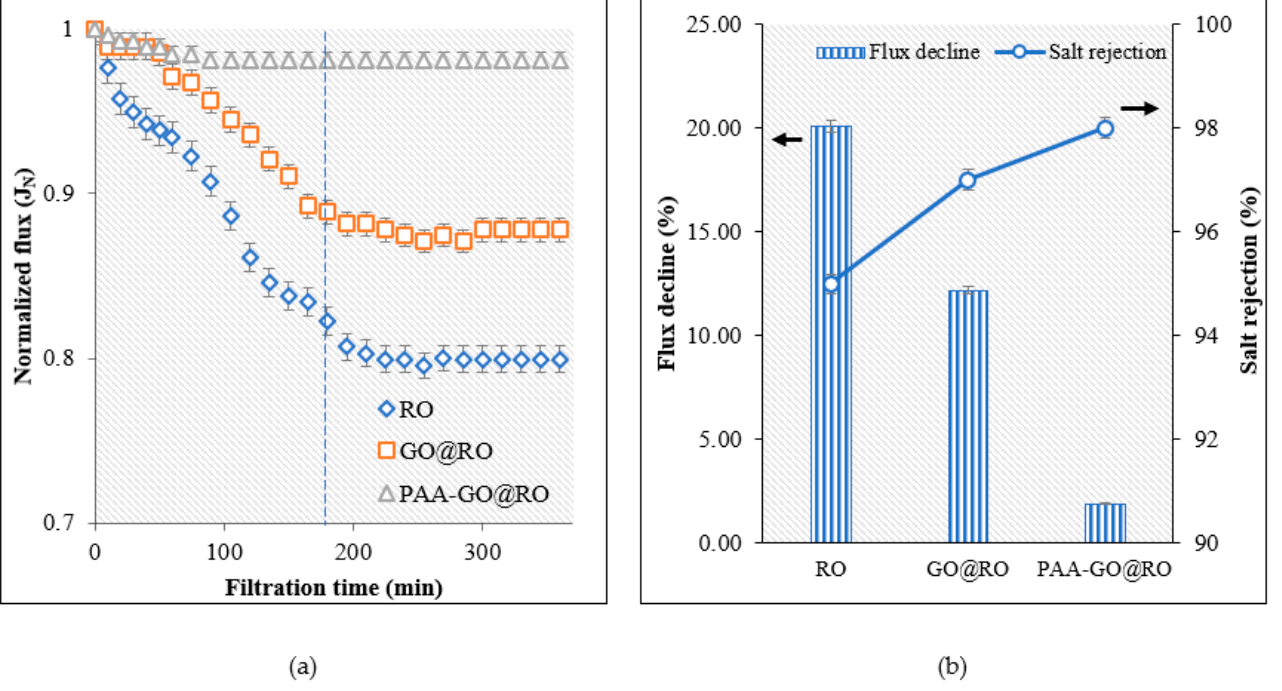
Figure 11. Inorganic fouling tests for the membranes ( a ) Decline of normalized flux with time, ( b ) Comparison of flux decline and salt rejection at the end of experiments.